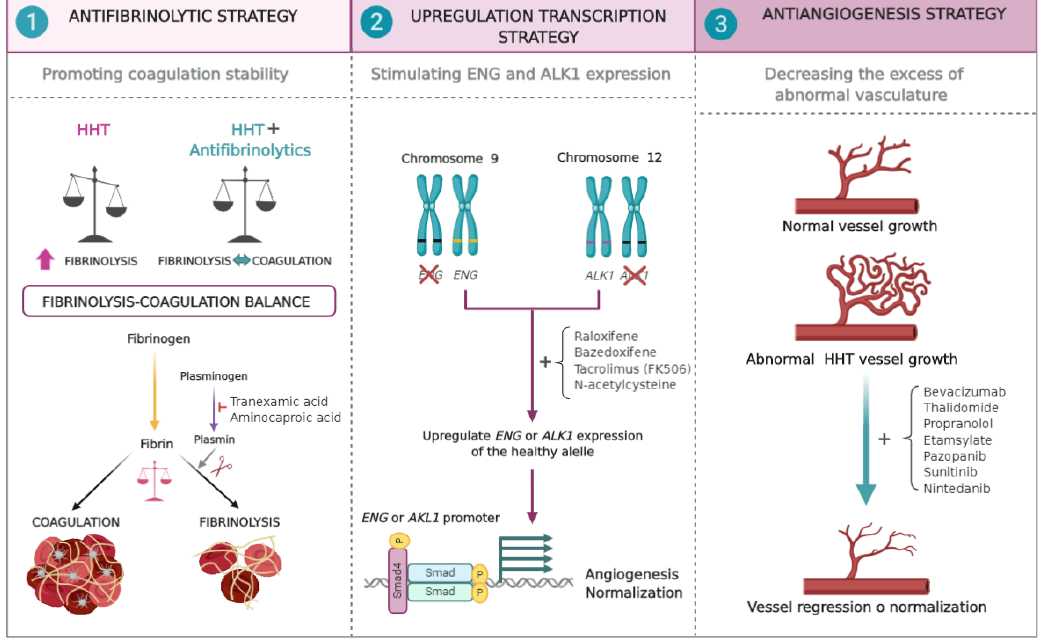
Figure 3. Therapeutic strategies of pharmacological treatments in HHT. (1) Antifibrinolytic